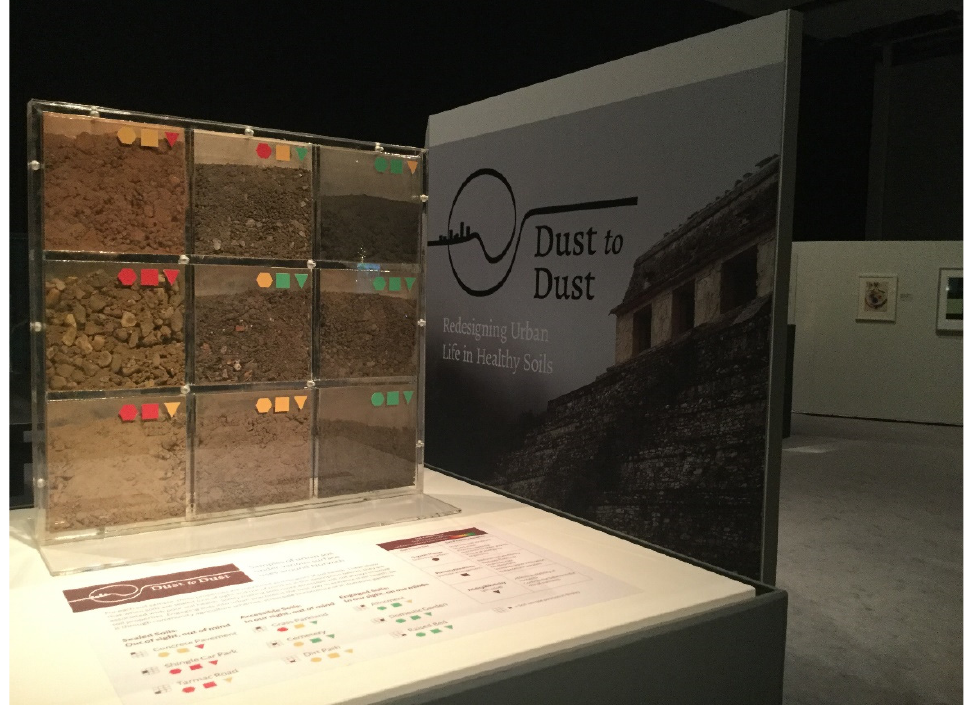
Figure 3. The soil display opening the Dust to Dust: Redesigning urban life in healthy soils exhibition at the Sainsbury Centre, Norwich, UK, which generates public awareness that productively used urban soils have the most beneficial properties. (Image credit: Daniel Evans).